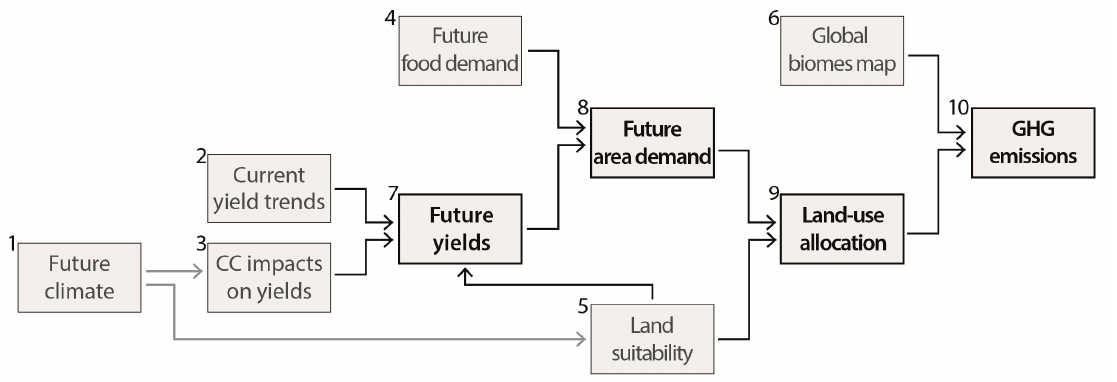
Figure 2. Work flow for the study. Grey boxes represent previously existing data: 1, future climate predictions from GCMs (most notably, HADCM3); 2, Ray et al. [19]; 3, Iglesias and Rosenzweig [10]; 4, FAO [20]; 5, Global Agro-Ecosystem